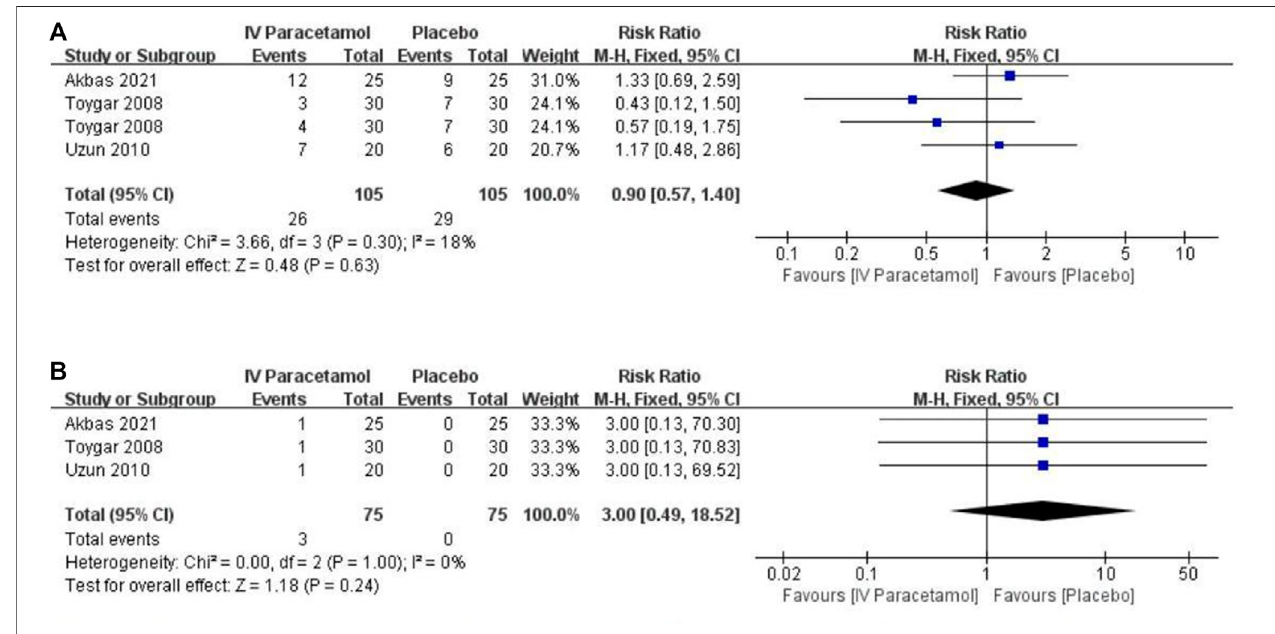
FIGURE 5 | Forest plot showing the incidence of (A) nausea and vomiting and (B) urinary retention. IV, intravenous. CI, con fi dence interval.